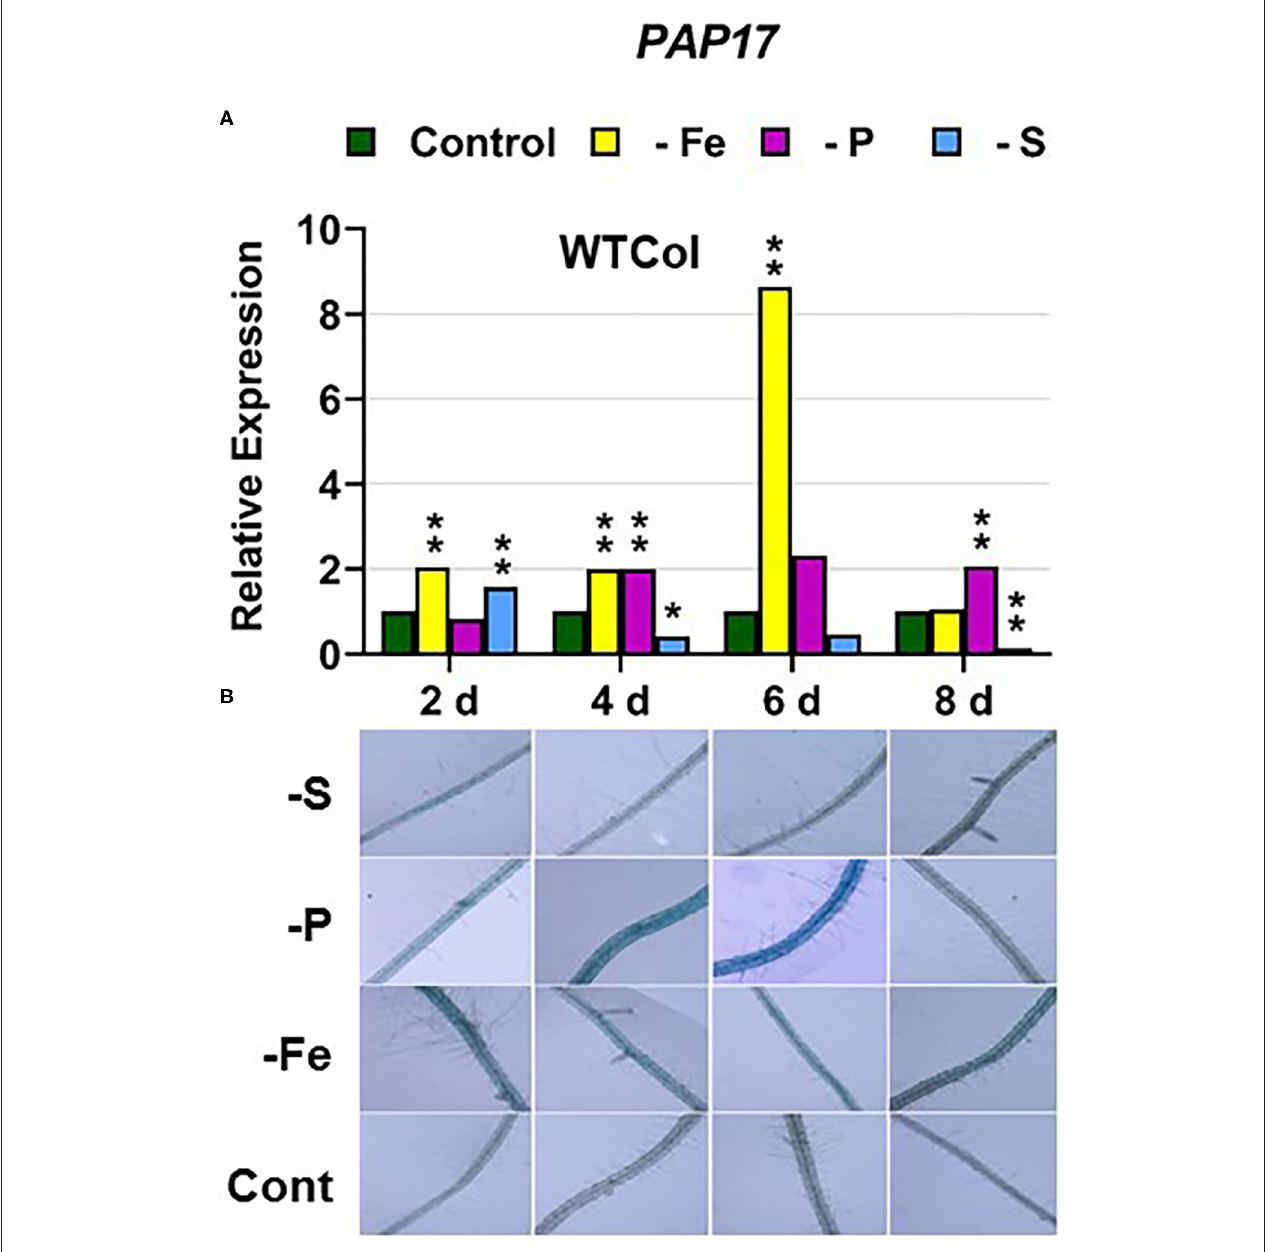
FIGURE 5 | Effect of Fe, P or S deficiency on the expression of the P-related gene PAP17 (A) ; and of phosphatase activity (PA; B ) in roots of the Arabidopsis WT Columbia. Treatments and gene expression determination as in Figure 1 . After 2, 4, 6, and 8 days of the treatments, PA was determined in several plant replications and representative results are presented. Within each day and genotype, * or ** indicate significant differences ( P < 0.05 or P < 0.01) in relation to the control treatment.